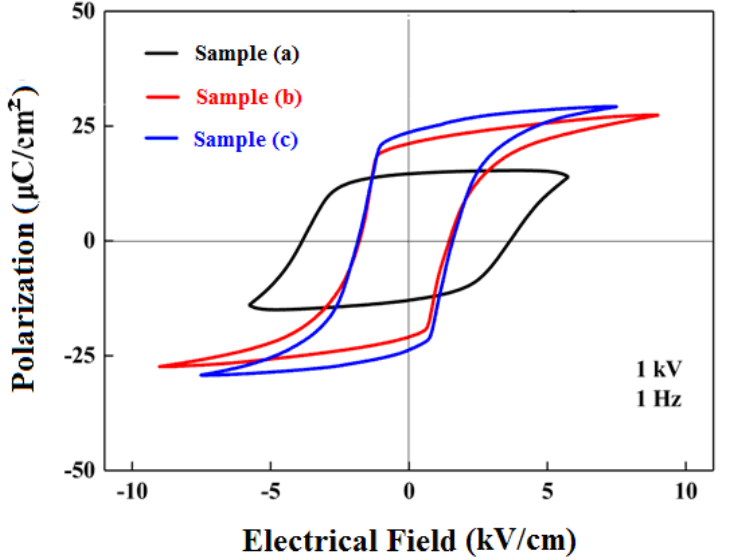
Figure 4. The polarization versus electric field (P − E) of the different crystal wafers.